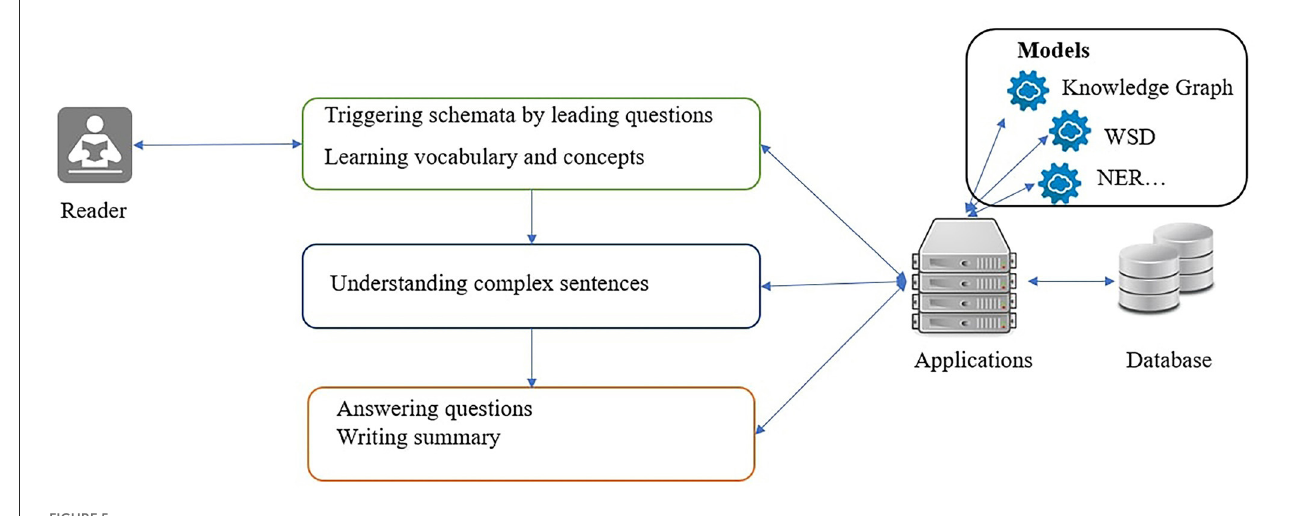
FIGURE5 Interactions between readers and the reading bot.